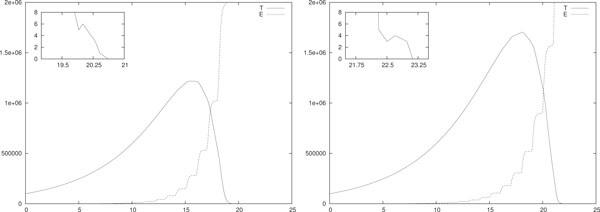
Single run, IL-2 mono-therapy. Single-run of piece-wise constant (left) and impulsive (right) IL-2 daily immunotherapy. In (left) A = 0.2 and di = 4 · 107/A for i = 1, . . . , 30. In (right) ui = 4 · 107 for i = 1, . . . , 30. In both cases T(0) = 105, E(0) = I(0) = 0 and pE = 20 · 0.1245. All the other parameters are as in Table 3.